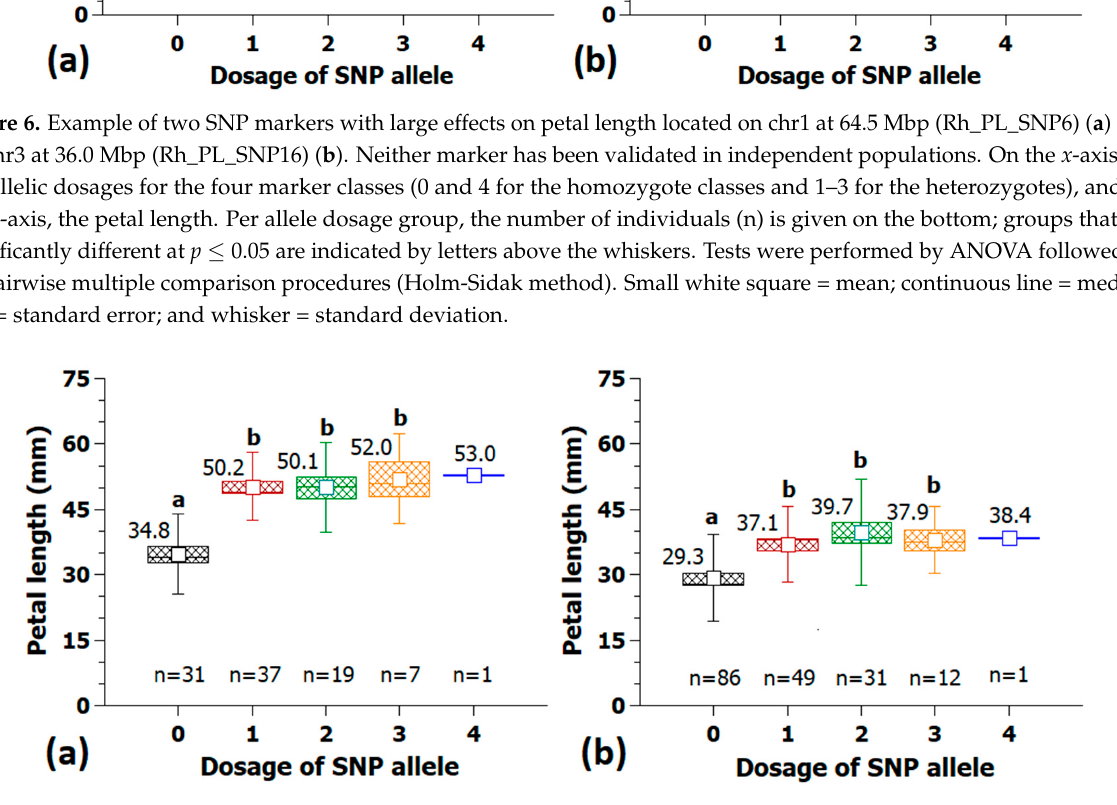
Figure 6. Example of two SNP markers with large effects on petal length located on chr1 at 64.5 Mbp (Rh_PL_SNP6) ( a ) and on chr3 at 36.0 Mbp (Rh_PL_SNP16) ( b ). Neither marker has been validated in independent populations. On the x - axis are the allelic dosages for the four marker classes (0 and 4 for the homozygote classes and 1–3 for the heterozygotes), and on the y -axis, the petal length. Per allele dosage group, the number of individuals (n) is given on the bottom; groups that are significantly different at p ≤ 0.05 are indicated by letters above the whiskers. Tests were performed by ANOVA followed by all pairwise multiple comparison procedures (Holm-Sidak method). Small white square = mean; continuous line = median; box = standard error; and whisker = standard deviation.